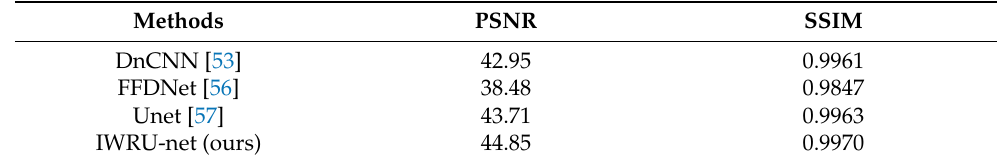
Table 3. Average PSNR (dB) and SSIM of different networks on LVW datasets for varying trans- parency rates of 0.5, 0.6, 0.7 and 0.8.